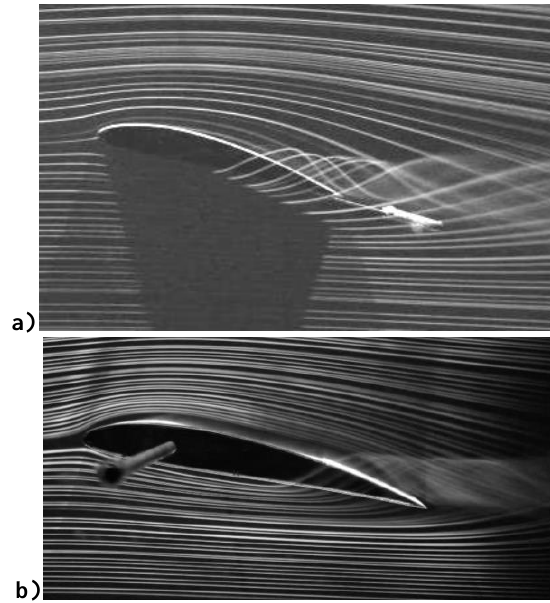
Fig. 4. Smoke wire results for Re=5x10 4 , α=12º and z/s=0.1 a) uncontrolled case, b) partial flexible airfoil .